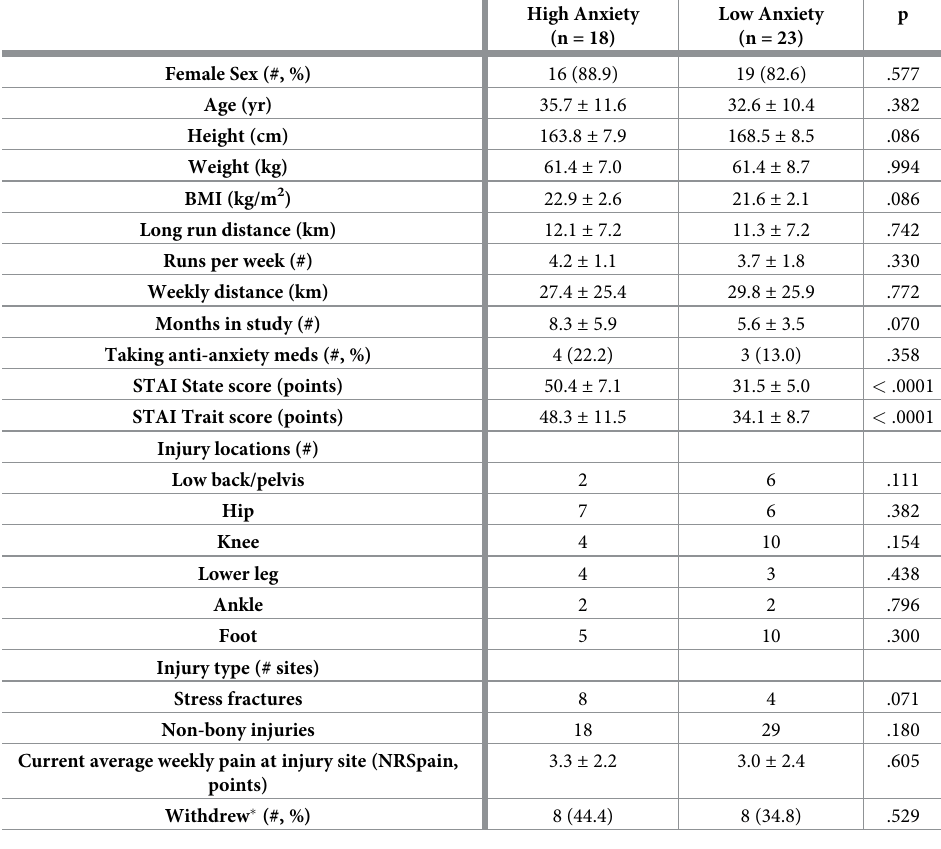
Table 1. Baseline characteristics in injured runners with and without high anxiety